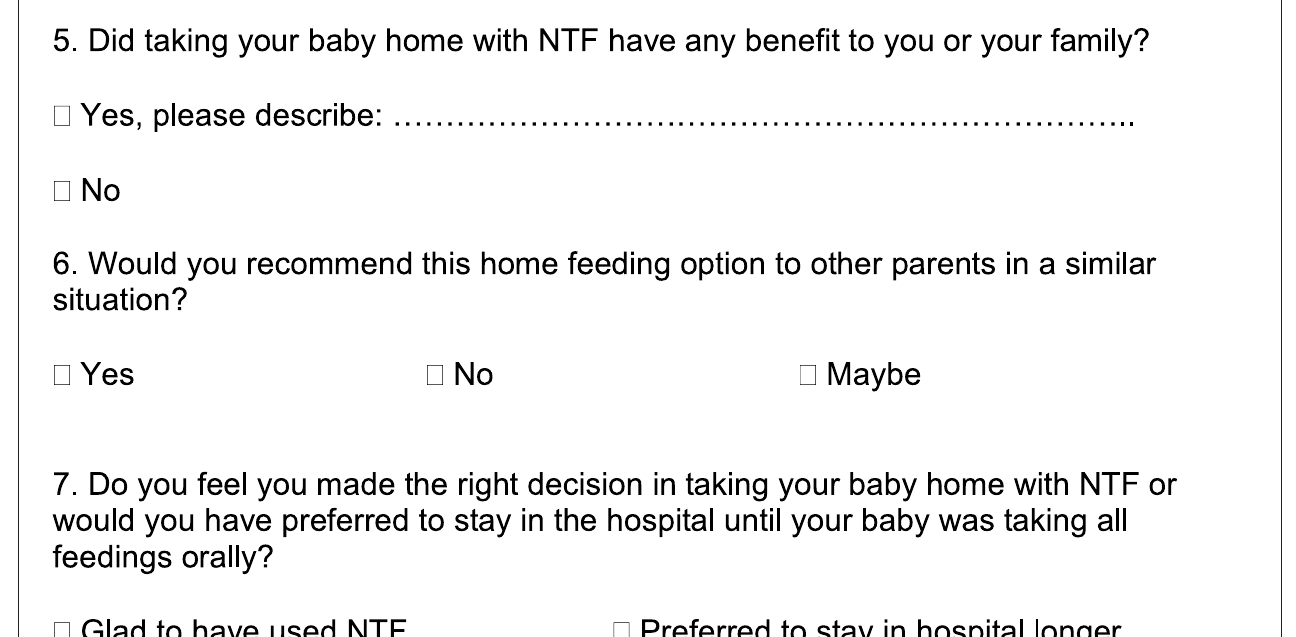
out at the outpatient clinic during a scheduled visit. Telephone interviews were conducted if the questionnaire was not sent back via